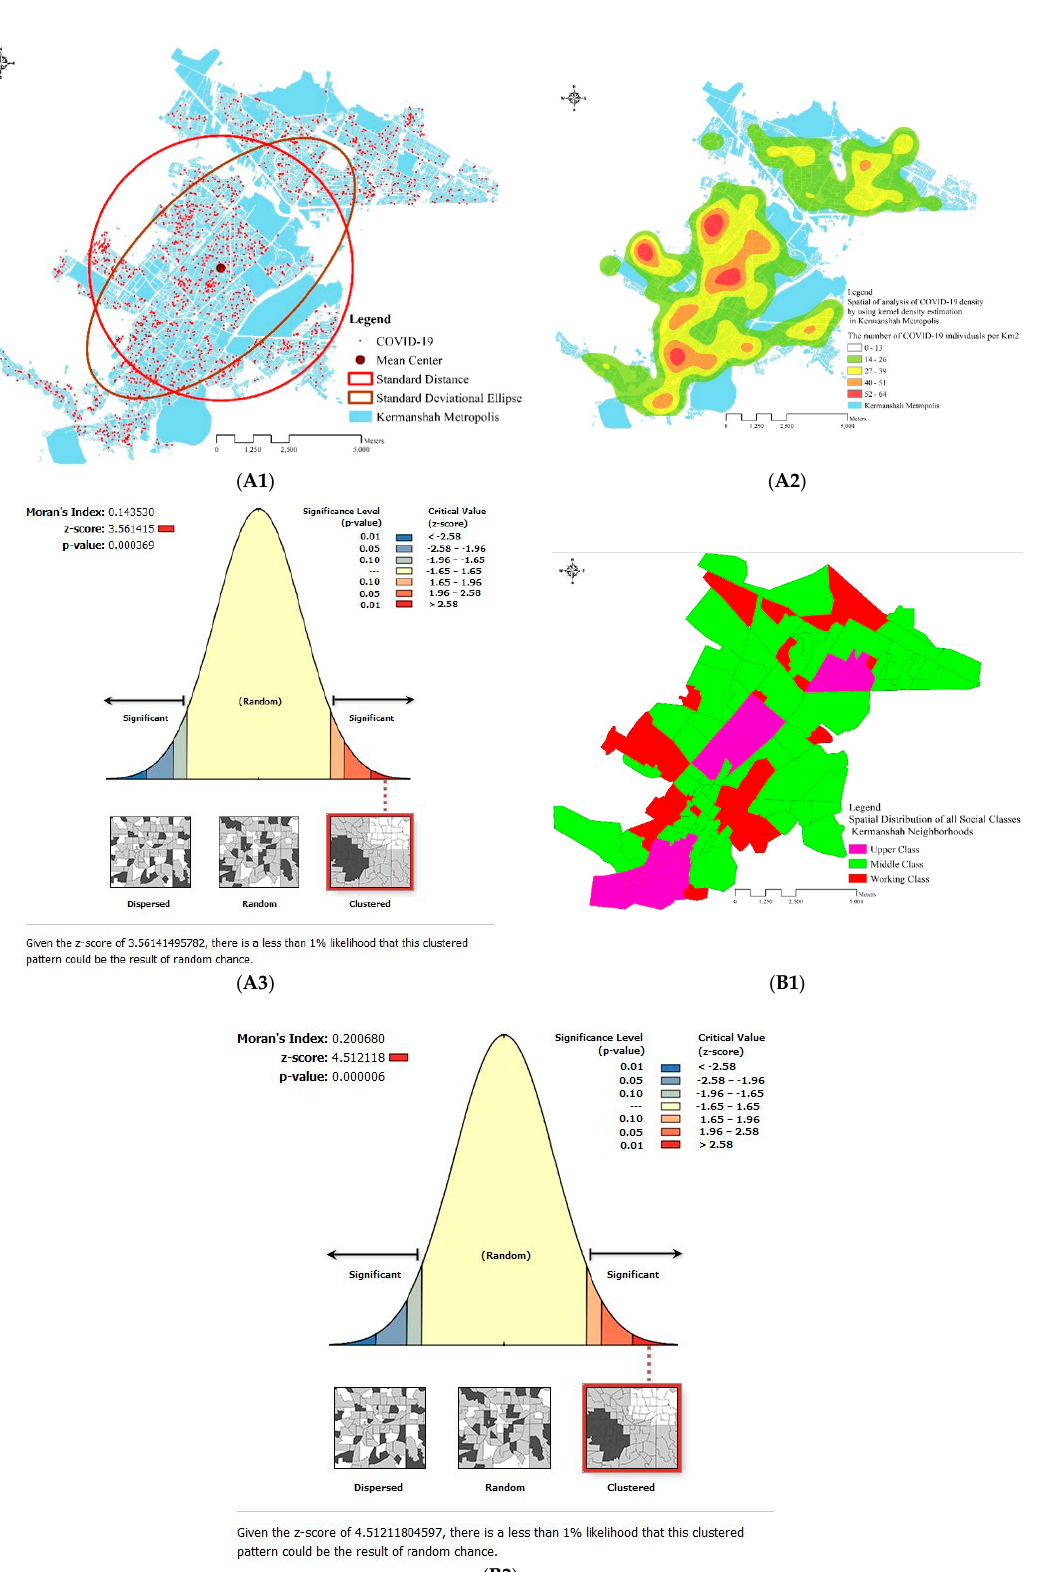
Figure 2. ( A1 ) Geographic distribution using Mean Center, Standard Distance, and Standard Deviational Ellipse. ( A2 ) Spatial analysis using Kernel Density. ( A3 ) Moran’s I for COVID-19 ( B1 , B2 ) Cluster and Outlier analysis for the social class classifications of all 106 neighbourhoods in Kermanshah metropolis based on Moran’s I. The results for COVID-19 in the neighbourhoods of Kermanshah metropolis are as follows: (a) the Moran’s I = 0.14 and (b) the Z score = 3.56 is less than 2.58 at the confidence level of 0.01, which is statistically significant. On the other hand, the computed values of social classes throughout the neighbourhoods in the metropolis are as follows: (a) Moran’s I = 0.20 and (b) the Z score = 4.51 is less than 2.58 at the confidence level of 0.01, which is statistically significant. Moran’s I indicate that COVID-19 and social classes exists in clusters across the neighbourhoods in Kermanshah metropolis (Figure 2B2,A3). Between March 2020 and June 2020, 2013 people were infected with COVID-19 (male = 1164 and female = 849). The mean age of patients was 45 ± 18.69. The mean age of men and women was 44.51 ± 18.62 and 45.69 ± 18.76, respectively. In the poor, middle, and rich neighbourhoods, the mean age was 46.91 ± 20.78, 44.51 ± 18.24, and 45 ± 18.69, respectively. The mean age of women in poor, middle class, and rich neighbourhoods was 50.10 ± 21.46, 44.64 ± 17.89, and 43.71 ± 17.08, respectively. In addition, the mean age of men in these neighbourhoods was 44.33 ± 19.84, 44.43 ± 18.48, and 44.85 ± 17.80, respectively. It can be observed that COVID-19 was most prevalent among the middle class in the Kermanshah metropolis. On the other hand, age group comparisons indicate that in poorer communities, the elderly were more susceptible to the disease. However, in the middle-class 0–14 age group and in affluent neighbourhoods, people in the 15–64 age group were more exposed to the disease (Table 1).